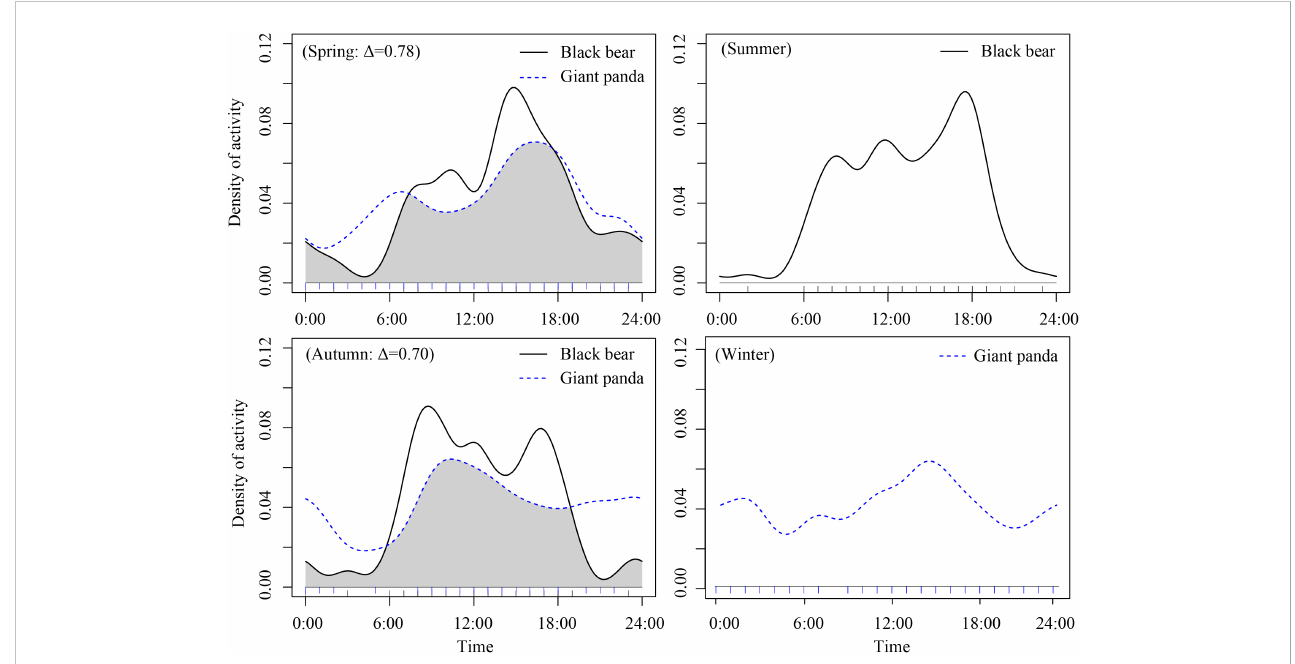
FIGURE 5 Density estimates of daily activity patterns and temporal overlap ( Δ ) of giant panda and Asiatic black bears across the four seasons in in Changing National Nature Reserve, China. The y-axis is the “ density ofactivity ” . The overlap area is denoted in grey.